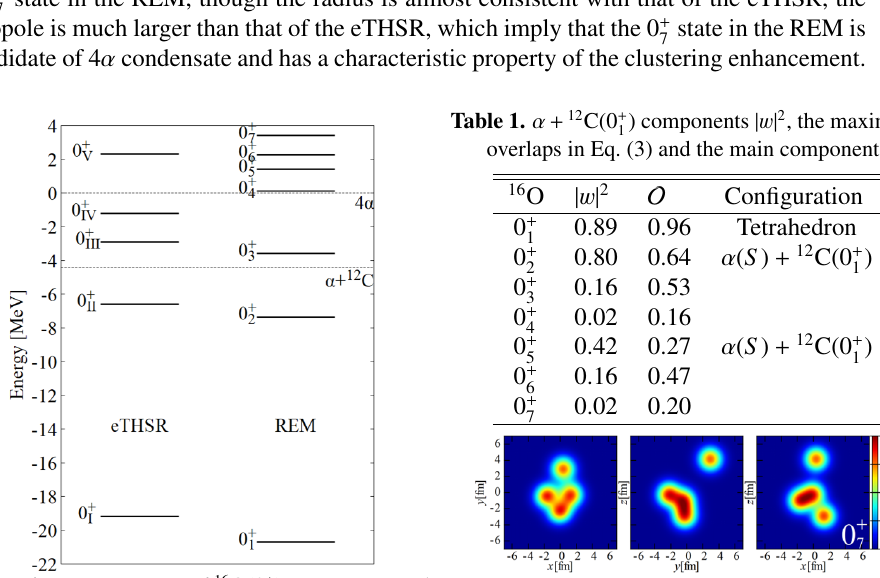
Figure 2. Density distribution of the intrinsic wave function maximized for 0 + state using Eq. 7